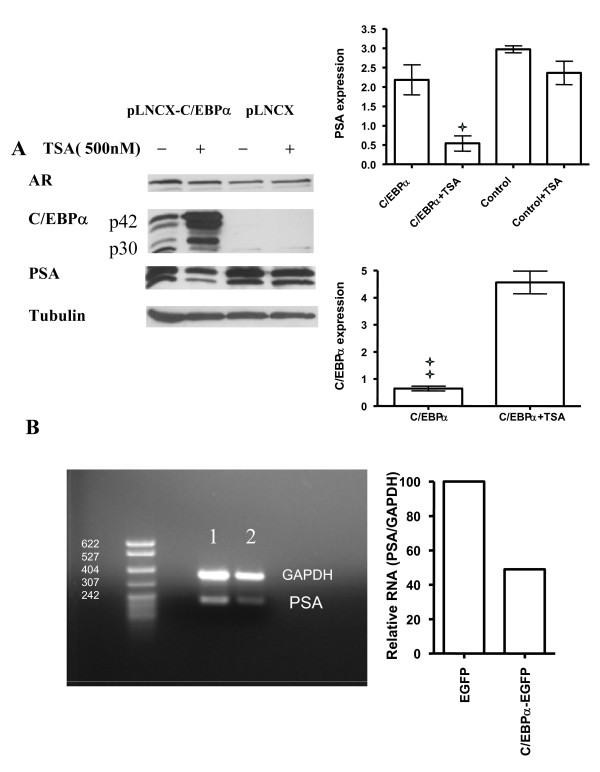
Expression of C/EBPα inhibits PSA expression through inhibition of the PSA promoter. A. Increasing expression of C/EBPα reduced protein levels of PSA in transduced LNCaP cells. The Clone 2 cells at passage 3 and the corresponding control cells were treated with 500 nM trichostatin A (TSA) for 48 hours. Whole cell protein extracts were again subjected to SDS-PAGE and western blot analysis performed. The expression of PSA and C/EBPα were expressed relative to β-tubulin by densitometry of the western blots. The results in the right panels are the means ± standard deviation of three independent experiments. For PSA expression a single star indicates a significant difference with a P < 0.05 (unpaired t-test) comparing C/EBPα to C/EBPα plus TSA. For C/EBPα expression double stars indicate a significant difference with a P < 0.01 (unpaired t-test). B. LNCaP cells were transiently transfected either with pEGFP-N2, the transfection control, or C/EBPα-pEGFP. After 48 hours EGFP positive cells were collected by cell sorting and RNA extracted from the EGFP positive cells. The PSA mRNA was amplified with RT-PCR as detailed in the Methods. In the left panel is shown the electrophoresis pattern of the PCR products from the cells transfected with pGFP-N2 (lane 1) and C/EBPα-pEGFP (lane 2). A densitometric scan of the electrophoretic pattern corrected for levels of GAPDH shows the relative amounts of PSA mRNA in the control versus C/EBPα transfected cells (right panel) with the columns in the right panel representing the means of two individual PCR reactions.